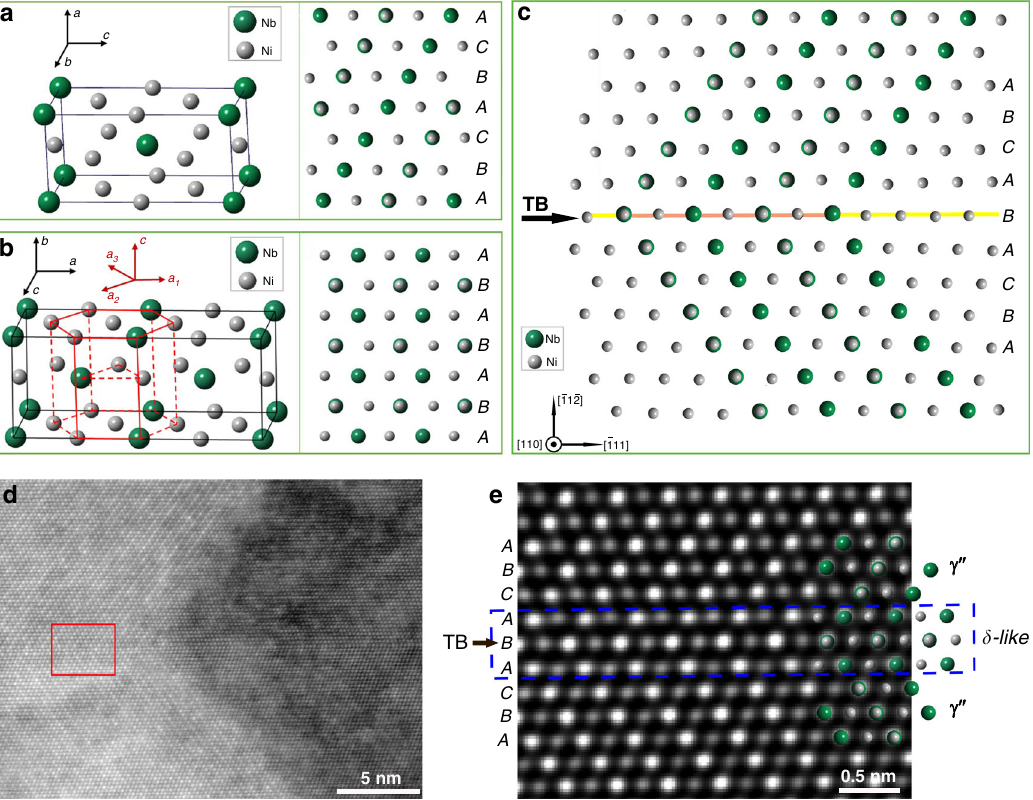
Fig. 2 Atomic structure and crystal models of D0 22 -Ni 3 Nb γ ″ and D0 a -Ni 3 Nb δ precipitates, and the atomic structure of the precipitate at TBs. a Unit cell of D0 22 -Ni 3 Nb γ ″ and atomic structure of γ ″ viewing along [110] direction with ABCABC packing sequence; b two orthorhombic cells of D0 a -Ni 3 Nb δ and its relationship with a hexagonal close-packed unit cell and atomic structure of δ viewing along [100] direction with ABAB packing sequence; c schematic crystal models of a TB with V-shaped γ ″ ; d an HAADF STEM image showing the atomic structure of two γ ″ across a TB with incident electron beam along [110] zone axis; e the corresponding IFFT image of the framed region in ( d ), and crystal models of γ ″ [110] and δ [100] are overlapped on part of the atomic